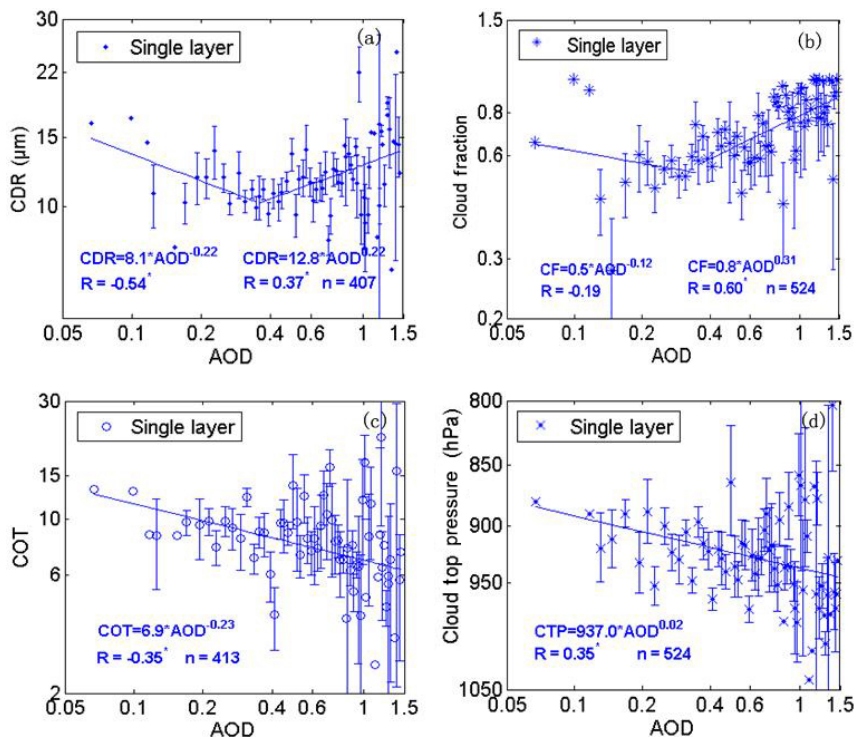
Figure 7. Scatter plots of cloud parameters versus AOD over YRD on log–log scale for mixed-aerosol single-layer clouds: (a) CDR, (b) CF, (c) COT and (d) CTP. The lines present the least-square fits, and the resulting relations are presented in each figure. The error bars indicate the statistical uncertainties as in Fig.